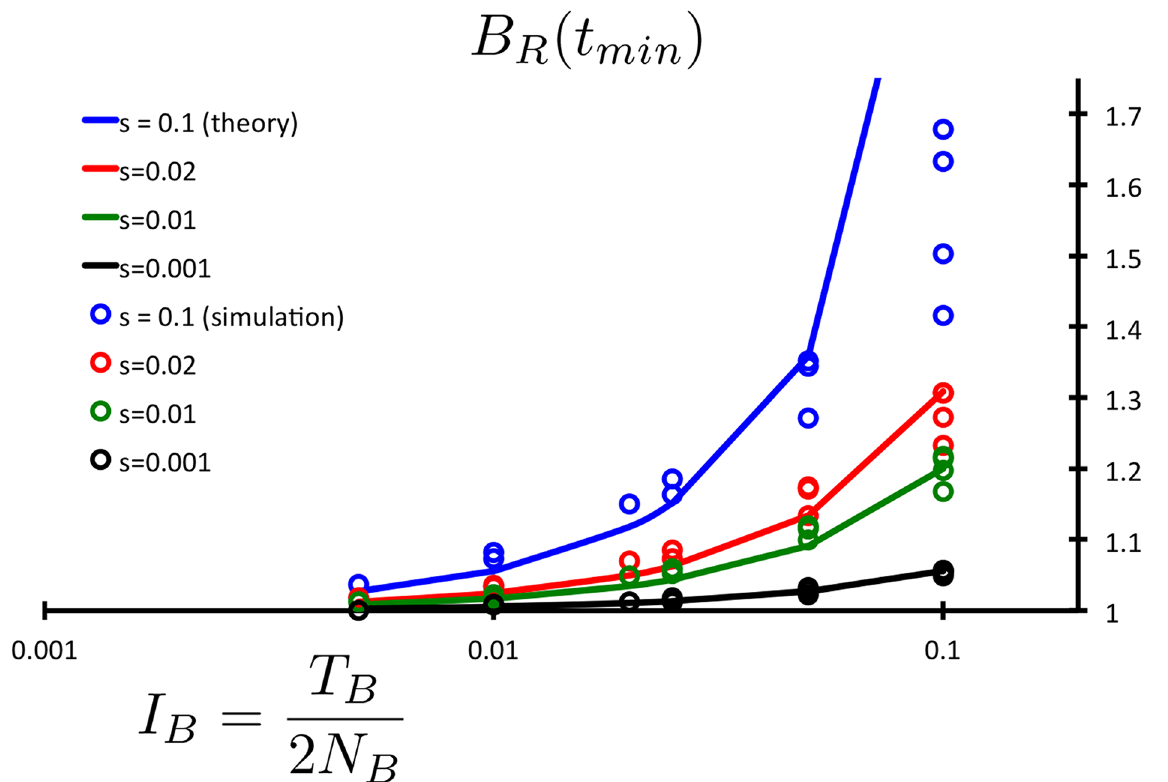
Fig 4. Comparisons of analytic and simulation results. Maximum response values of the burden ratio B R ( t min ) are plotted for recessive selection as a function of bottleneck intensity. A wide range of parameter sets is plotted with all combinations of 2 N B = {2000,1000,400,200,100}, s = {0.1,0.02,0.01,0.001}, T B = {200,100,50,20,10}, each simulated for 10 8 nucleotide sites. For relatively low intensity bottlenecks we note excellent agreement over the parameter ranges plotted. Intensities with I B = T B /2 N B > 0.1 are excluded, as the single-generation bottleneck scaling breaks down in favor of a long bottleneck scaling. The approximation necessarily weakens for simulations that represent longer bottlenecks, and only for strong selective coefficients, as expected. This quantifies the limitations of the single-generation bottleneck approximation, as we observe substantial deviation only around I B = 0.1 and with selection strength s =